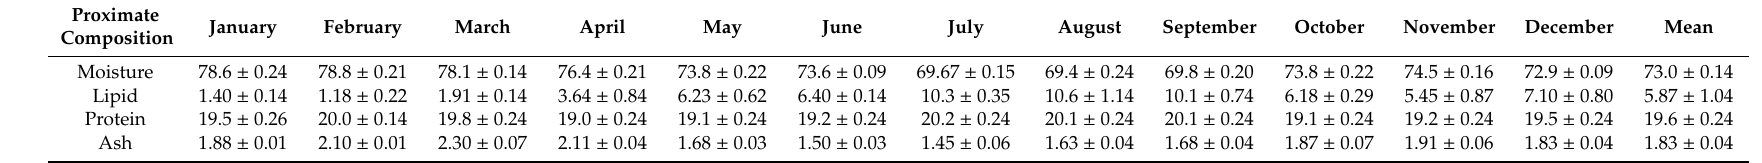
Table 1. Changes in proximate composition (g / 100 g EP) of sardines over 12 months ( n = 6).